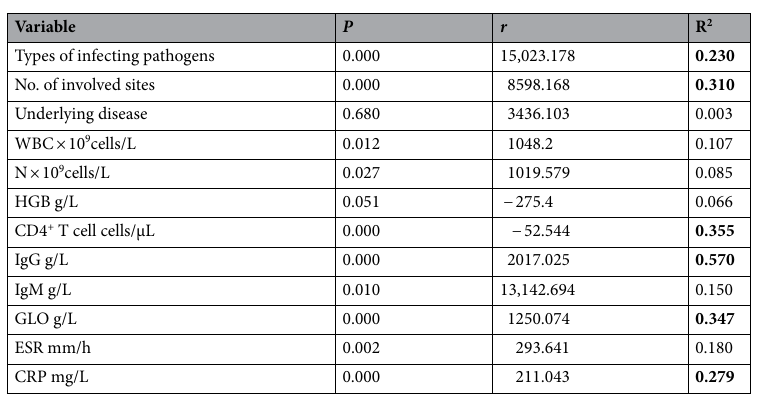
Table 2. Results of the univariate analysis for AIGA positivity (n = 92). Data were collected under sterile conditions before the patient received antimicrobial therapy and during the active stage of the infection.